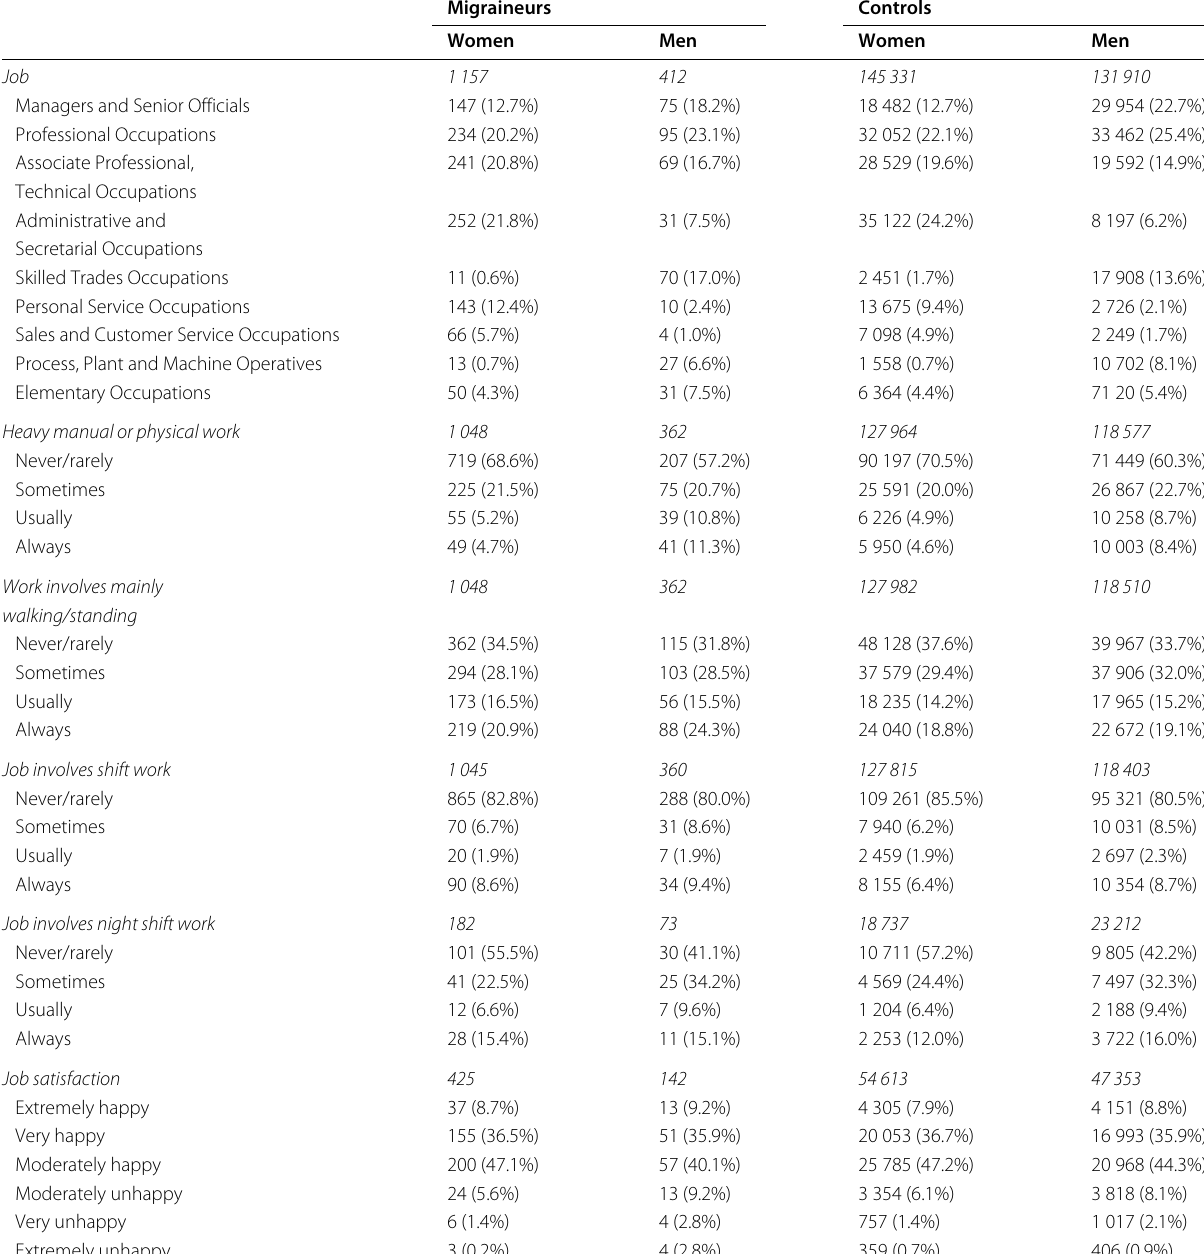
Table 2 Descriptive statistics of job-related